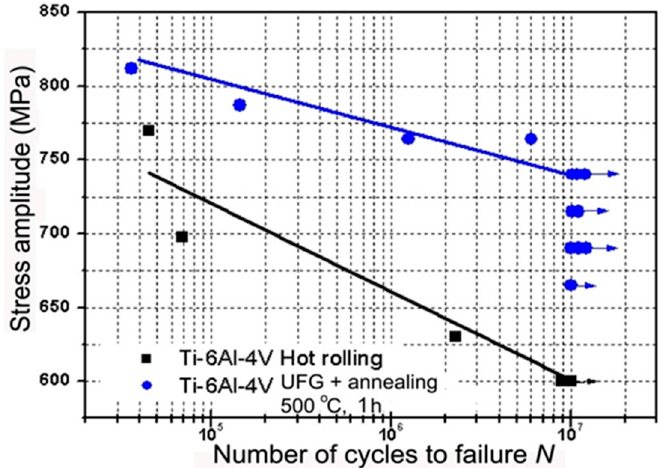
Figure 3. Fatigue test results of initial coarse-grained material and UFG material after annealing at 500 ◦ C, 1 h.